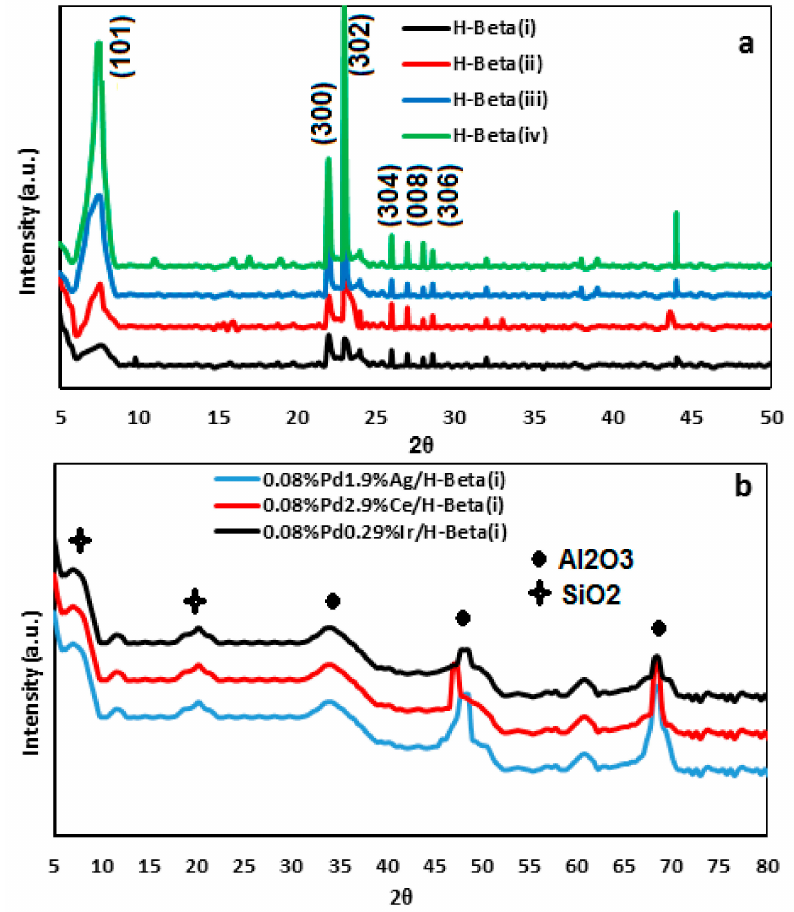
Figure 5. ( a ) X-ray powder diffraction (XRD) patterns of the parent Beta zeolite with different SDA; ( b ) XRD patterns of the corresponding optimum